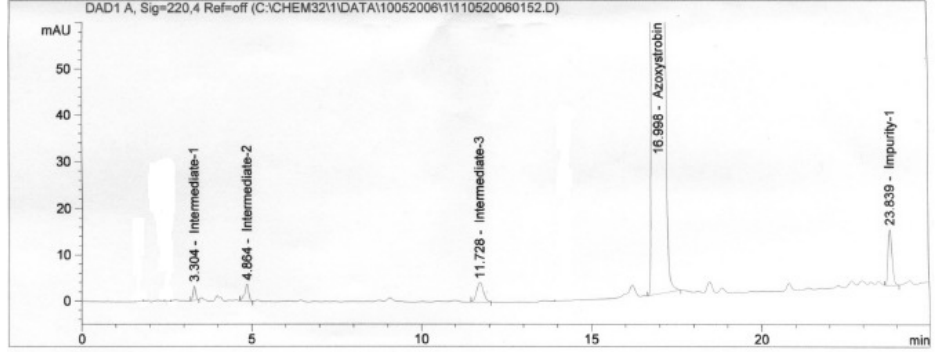
Figure 3 . HPLC chromatogram of Azoxystrobin showing an impurity at 23.839 min.